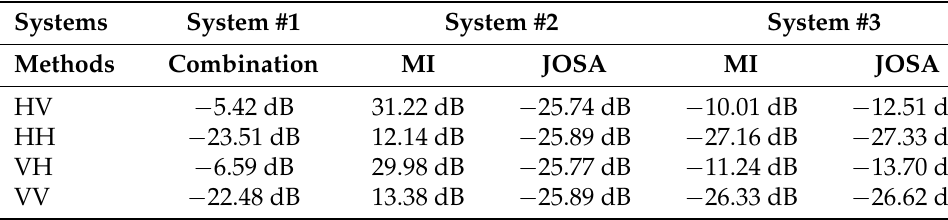
Table 2. AASR Performance (PRF = 3756 Hz).